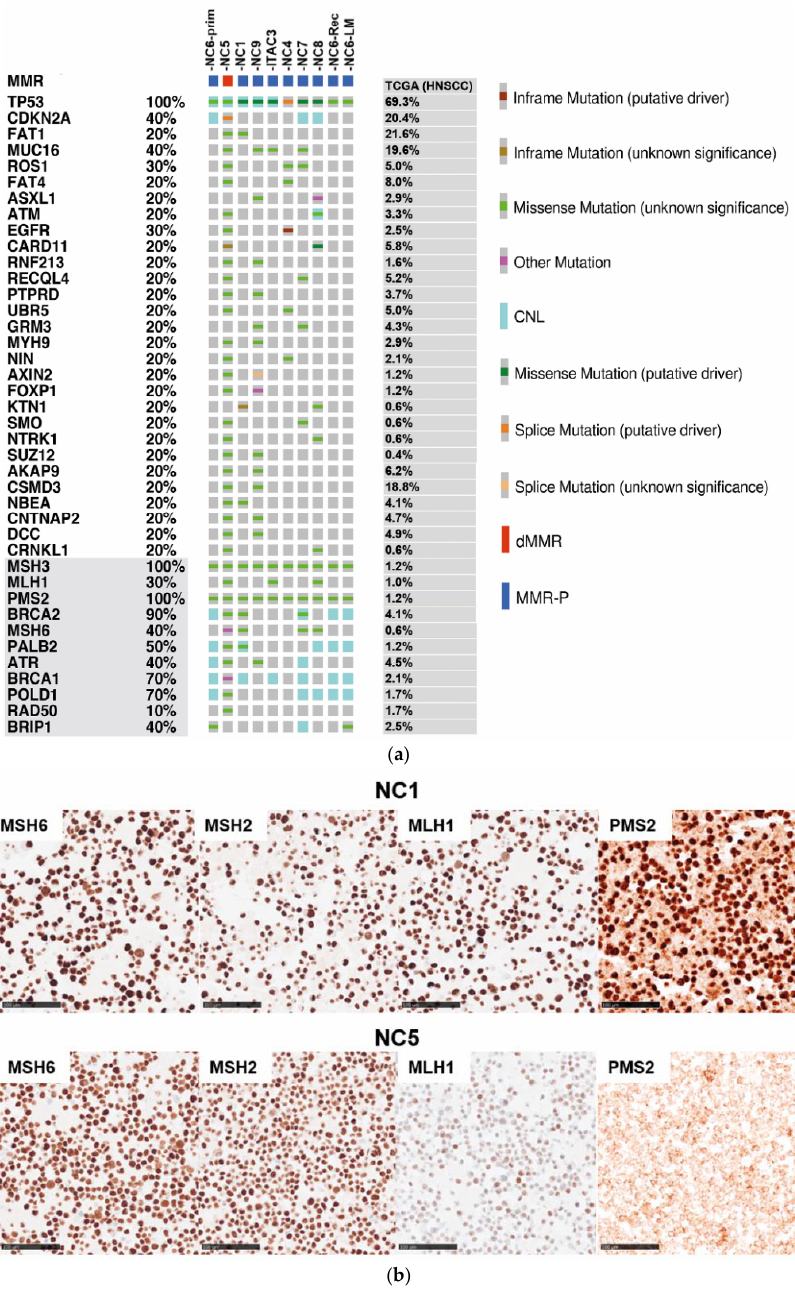
Figure 2. Putative driver mutations in cancer-associated genes and genes of DNA repair of sinonasal cell lines. ( a ) Recurrently mutated cancer genes in the cell lines were listed in comparison to TCGA data of head and neck squamous cell cancer (HNSCC); genes belonging to the DNA repair system shaded in gray. Potential driver mutations were found in the TP53 , EGFR , CDKN2A , CARD11 and KTN1 genes. Copy number loss (CNL) of BRCA2 and genes belonging to the homologous DNA repair (HR) as well as TP53 and CDKN2A were found in the cancer cell lines. Mismatch repair genes frequently carried gene variations, which were classified as benign according to ClinVAR database, except for the NC5 (cid:48) s MLH1 mutation, a somatic mutation with an allelic fraction of 99.8%, situated in the coding sequence for the ATPase region of MLH1 protein. ( b ) Immunohistochemical staining of MMR proteins revealed significant loss of MLH1 expression compared to the other cell lines (regular expression in NC1), followed by a complete loss of PMS2 protein expression but regular expression of MSH6 and MSH2. Scar bar 100 µ